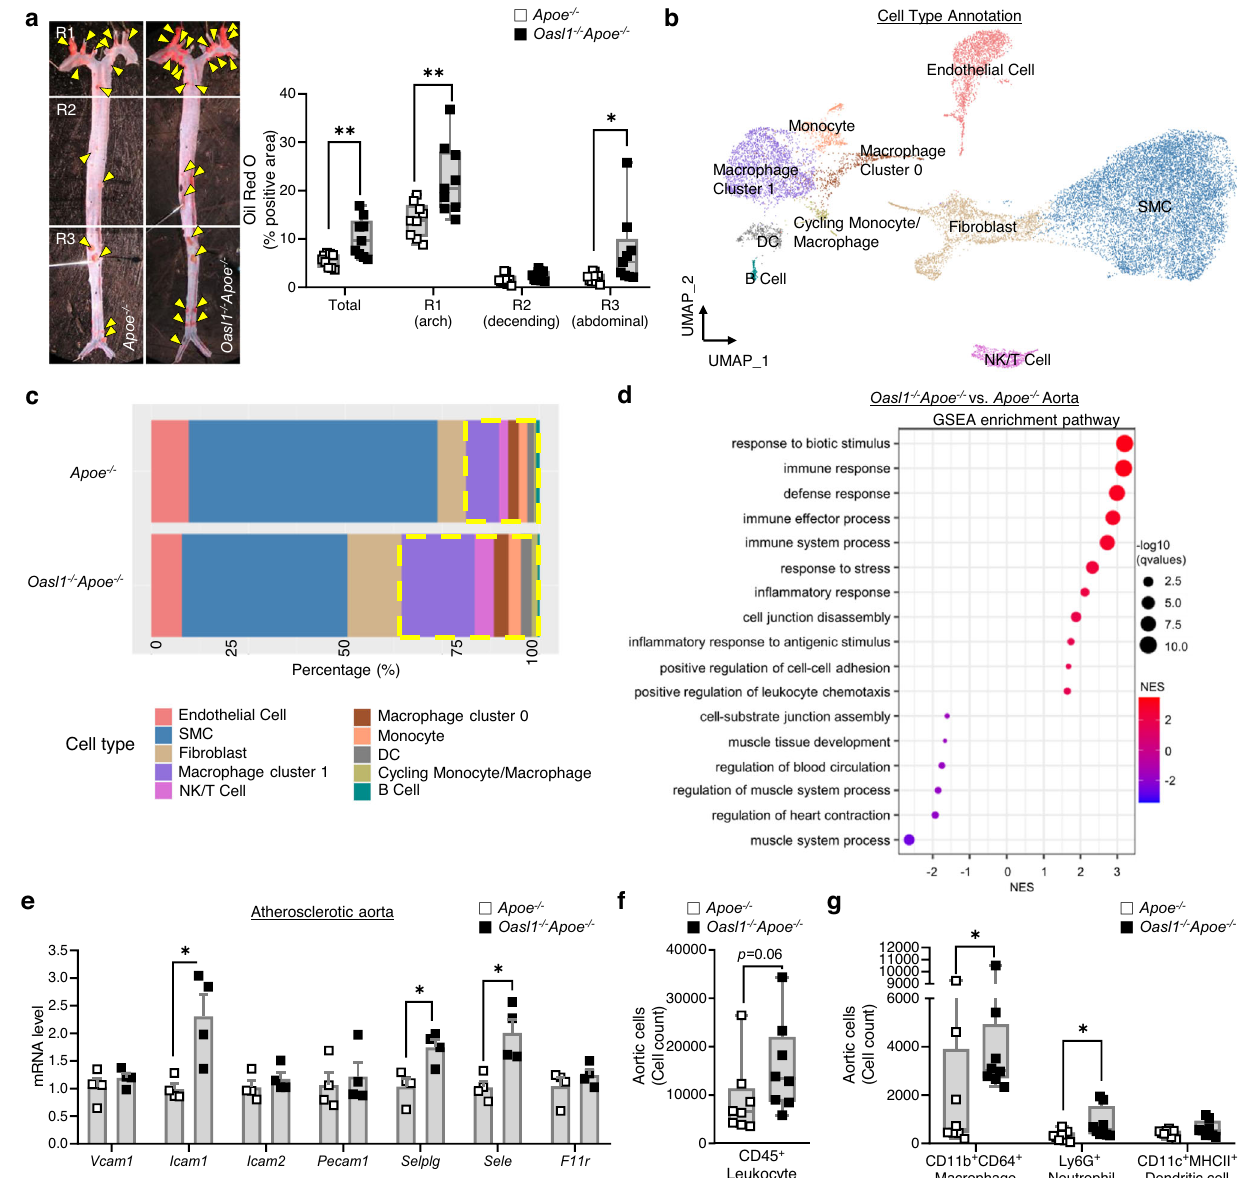
Fig. 2 | Oasl1 de fi ciency increases endothelial dysfunction, leading to vascular in fl ammation and leukocyte in fi ltration into the lesion. Apoe − / − and Oasl1 − / − Apoe − / − mice were fed a normal chow diet (NCD) for 28 weeks to allow athero- sclerotic conditions to develop. a Left: Oil red O-stained lesions in whole aortas. Right: Quantitation of stained areas in en face preparations (Total: p =0.0040, R1: p =0.0071, R2: p =0.1175, R3: p =0.0484, n =9 per group). Yellow arrowhead: pla- queinaorta. b – d Analysisofthetranscriptomesofsinglecellsfromatherosclerotic aortas using the 10x Genomics platform. b Uniform manifold approximation and projection(UMAP)plotof20,876totalaorticcells,coloredbyclusters. c Bargraphs showing the relative proportion of each cell type per group. d Dot plot showing Gene Set Enrichment Analysis (GSEA) according to the normalized enrichment score (NES) for Gene Ontology (GO) terms of aortas from Oasl1 − / − Apoe − / − versus with the littermate control Oasl1 fl / fl Apoe − / − mice (Fig. 3d), whereas they were no different in Oasl1 fl / fl Lyz2 -cre + Apoe − / − mice. We examined the role of OASL1 in ECs using a Cdh5 -cre/ERT2 system (Fig. 3e, Supplementary Fig. 6) and Oasl1 fl / fl Cdh5 -cre/ERT2 + Apoe − / − mice showed increased lesion formation compared with Oasl1 +/+ Cdh5 -cre/ ERT2 + Apoe − / − mice (Fig. 3f). This indicates that the EC-speci fi c de fi - ciency of Oasl1 promotes atherosclerosis in Apoe − / − mice, further demonstrating a potential endothelial effect.